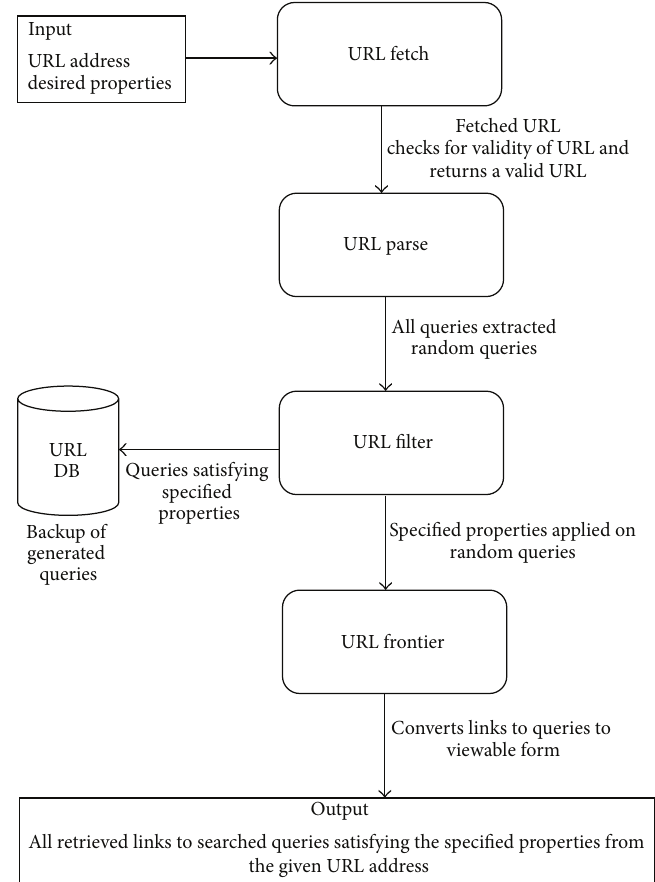
Figure 1: Block diagram of Web Crawling